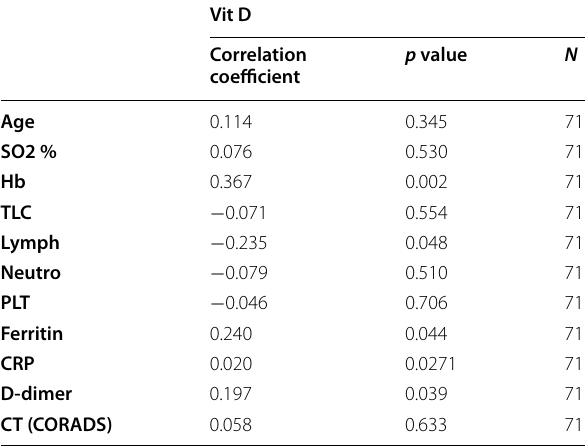
Table 4 Correlation between vitamin D and inflammatory markers